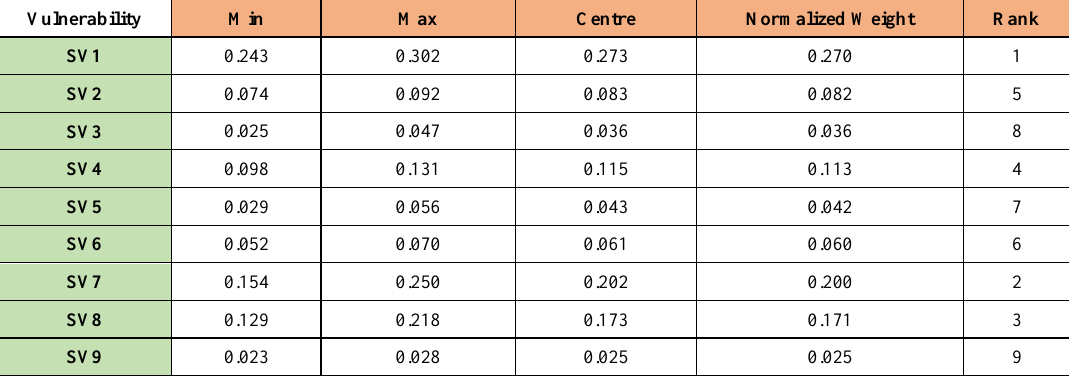
Table 5. Weights of the vulnerabilities calculated